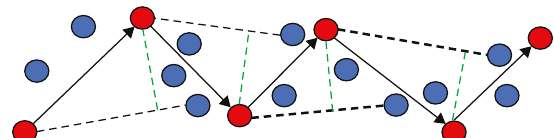
Figure 3: Illustration of the opening window (OPW)